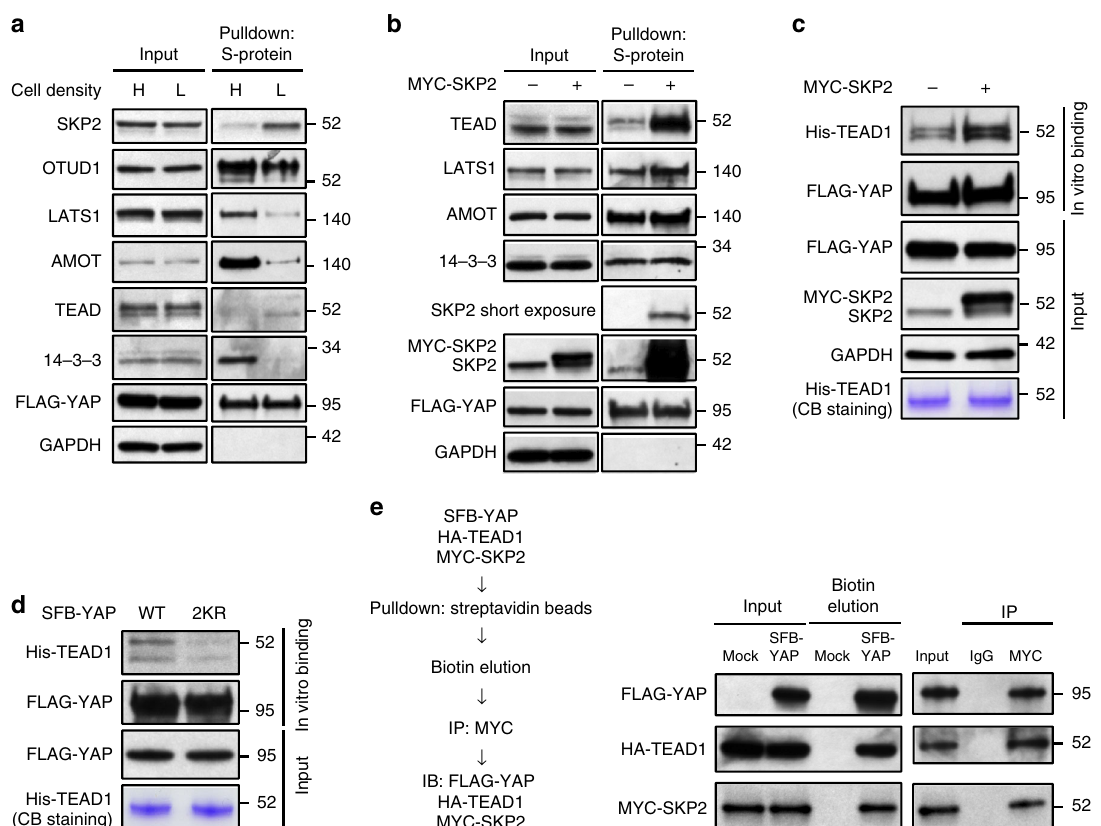
Fig. 7 SKP2 and K63-linked ubiquitination enhance the YAP-TEAD interaction. a HEK293A cells were stably transfected with SFB-YAP and then subjected to a pulldown assay with S-protein beads and immunoblotting with antibodies against YAP-interacting proteins. H: high density; L: low density. b The HEK293A SFB-YAP stable cell line was transfected with MYC-SKP2 and then subjected to a pulldown assay with S-protein beads and immunoblotting with antibodies against YAP-interacting proteins. c The HEK293A SFB-YAP stable cell line was transfected with MYC-SKP2. SFB-YAP was pulled down with S- protein beads and then incubated with His-TEAD1 protein puri fi ed from bacteria. After in vitro binding, the proteins bound to S-protein beads were eluted by boiling in Laemmli sample buffer and immunoblotted with antibodies against His and FLAG tags. d HEK293T cells were transfected with SFB-YAP (WT or the 2KR mutant). SFB-YAP was pulled down with S-protein beads and then incubated with His-TEAD1 protein puri fi ed from bacteria. After in vitro binding, the proteins bound to S-protein beads were eluted by boiling in Laemmli sample buffer and immunoblotted with antibodies against His and FLAG tags. e SKP2 forms a complex with YAP and TEAD1. HA-TEAD1 and MYC-SKP2 were co-transfected with or without SFB-YAP into HEK293T cells. SFB- YAP was pulled down with streptavidin beads and then eluted with biotin buffer. The eluded proteins were subjected to immunoprecipitation with a MYC- speci fi c antibody to pull down MYC-SKP2 and immunoblotting with antibodies against FLAG, HA, and